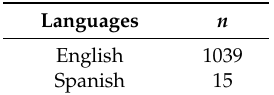
Table 3. Areas of knowledge.